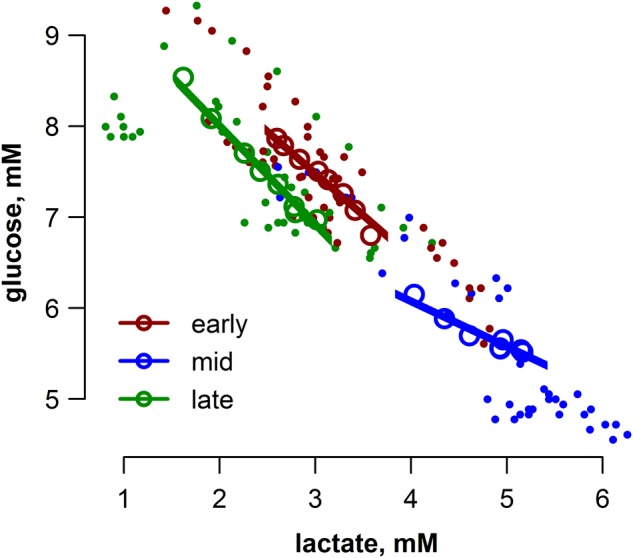
Glucose and lactate concentrations were inversely related during the stress response (LMM, F1,113 = 905.1, P < 0.0001), and this relationship varied by study group (lactate × state, F2,113 = 42.0, P < 0.0001); see main text for further description of statistical analysis. Each sample collected in this study for all study animals is represented by filled symbols and colour coded according to moulting state (early, mid or late). Fitted regression lines are derived from the LMM model fits, and marginal r2 (mr2) values are shown for each group. Open circles are average values at each sampling time (0–150 min) within the study group and are shown for visual clarity only.